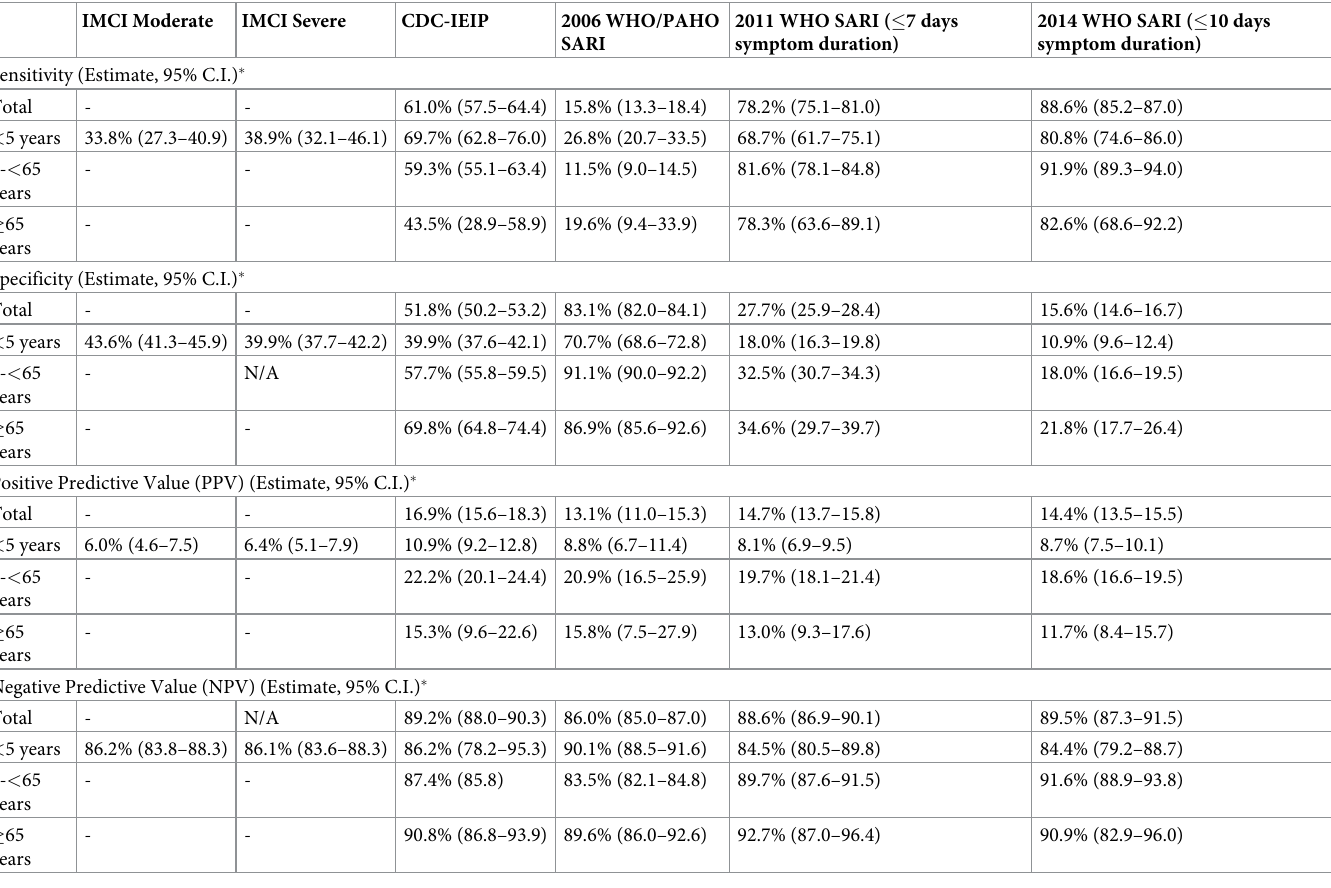
Table 3. Sensitivity, specificity, Positive Predictive Values (PPV), and Negative Predictive Values (NPV) for laboratory-confirmed influenza infection by case definition.